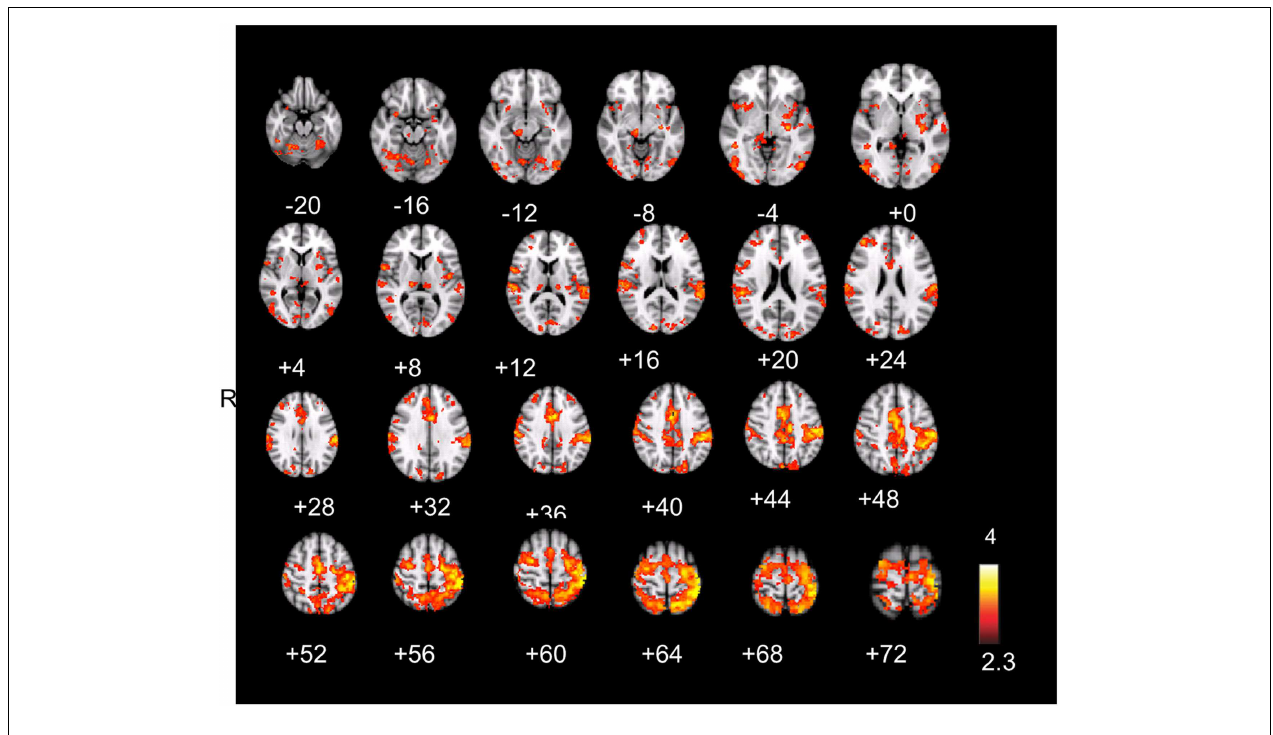
(somatosensory cortex), bilateral inferior and superior parietal lobules, parietal occipital junction, superior/middle and inferior frontal gyrus, precuneus, and bilateral cerebellum.The legend shows z -score value associated with the color map.The statistical parametric map has a threshold of z > 2.6; p < 0.05 (cluster-corrected). For a full list of activated regions, see TableA2